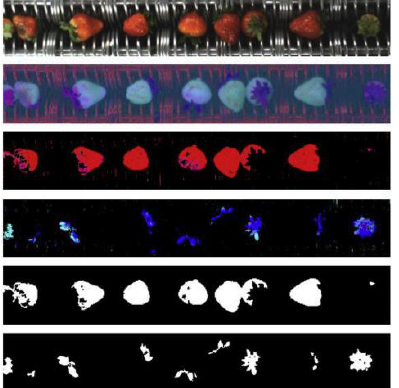
Figure 3. Image recognition assisted water jet in removing strawberry calyx ([50], adapted from “Design and testing of an automated high -throughput computer vision guided waterjet knife straw- berry calyx removal machine” with permission from Elsevier,